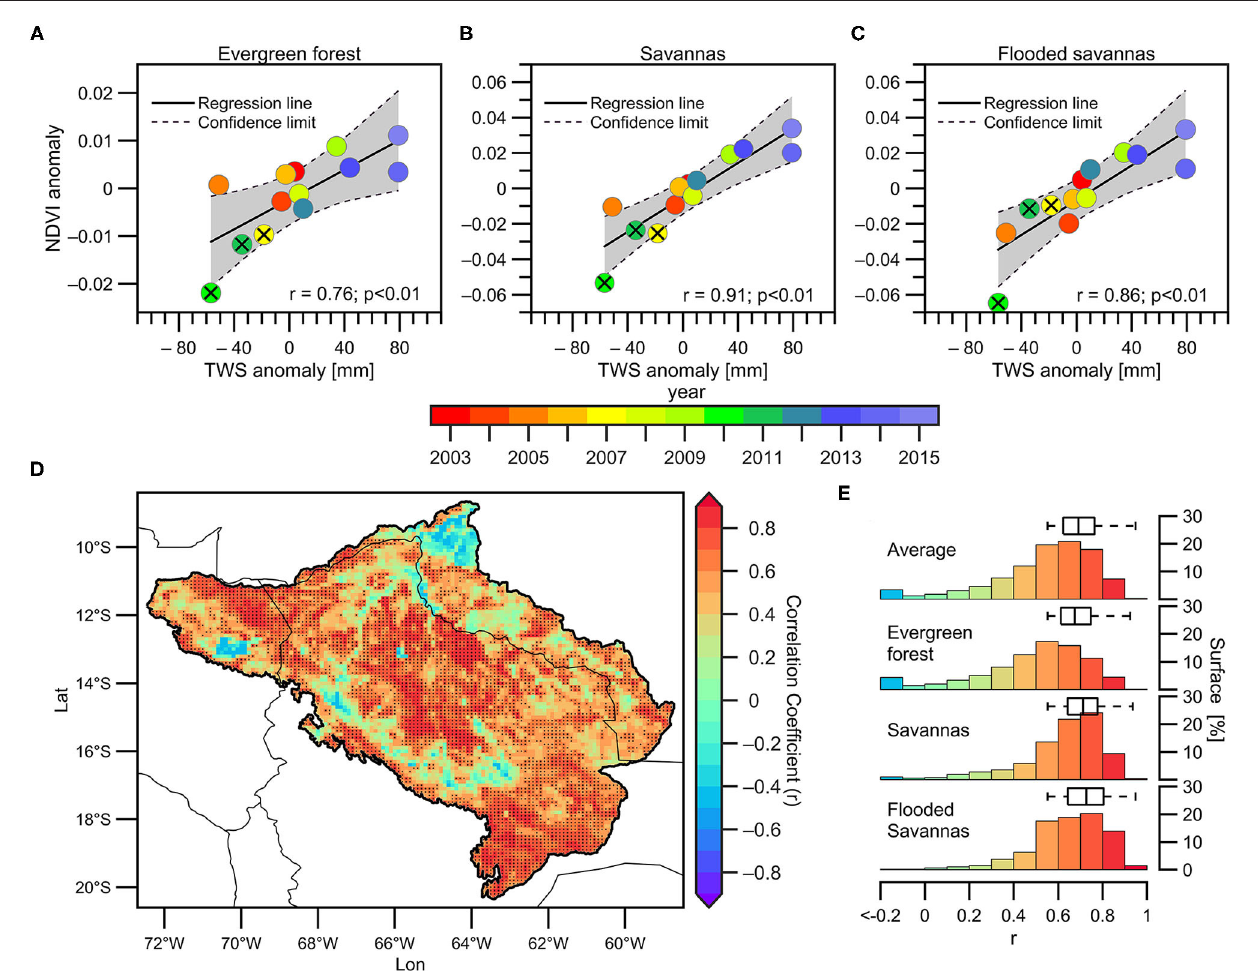
FIGURE 10 | (A–C) Scatterplots between TWS anomalies averaged over the basin (during the JASO season) and average NDVI (during the VDS) in (A) evergreen forests, (B) savannas, and (C) flooded savannas. The corresponding years, the regression line, the confidence interval (95%), the correlation coefficients and the p -value are indicated. (D) 2003–2015 spatial correlation (0.05 ◦ spatial resolution) between TWS anomalies averaged over the upper Madeira Basin (during the JASO season) and NDVI anomalies in each grid point (during the VDS). The dark dots indicate significant correlations ( p < 0.05). (E) Bars represent the surface (in percentage) in different correlation ranges for the basin average and for each predominant cover type. Boxplots indicate significant correlation ranges ( p < 0.05) computed in (D)